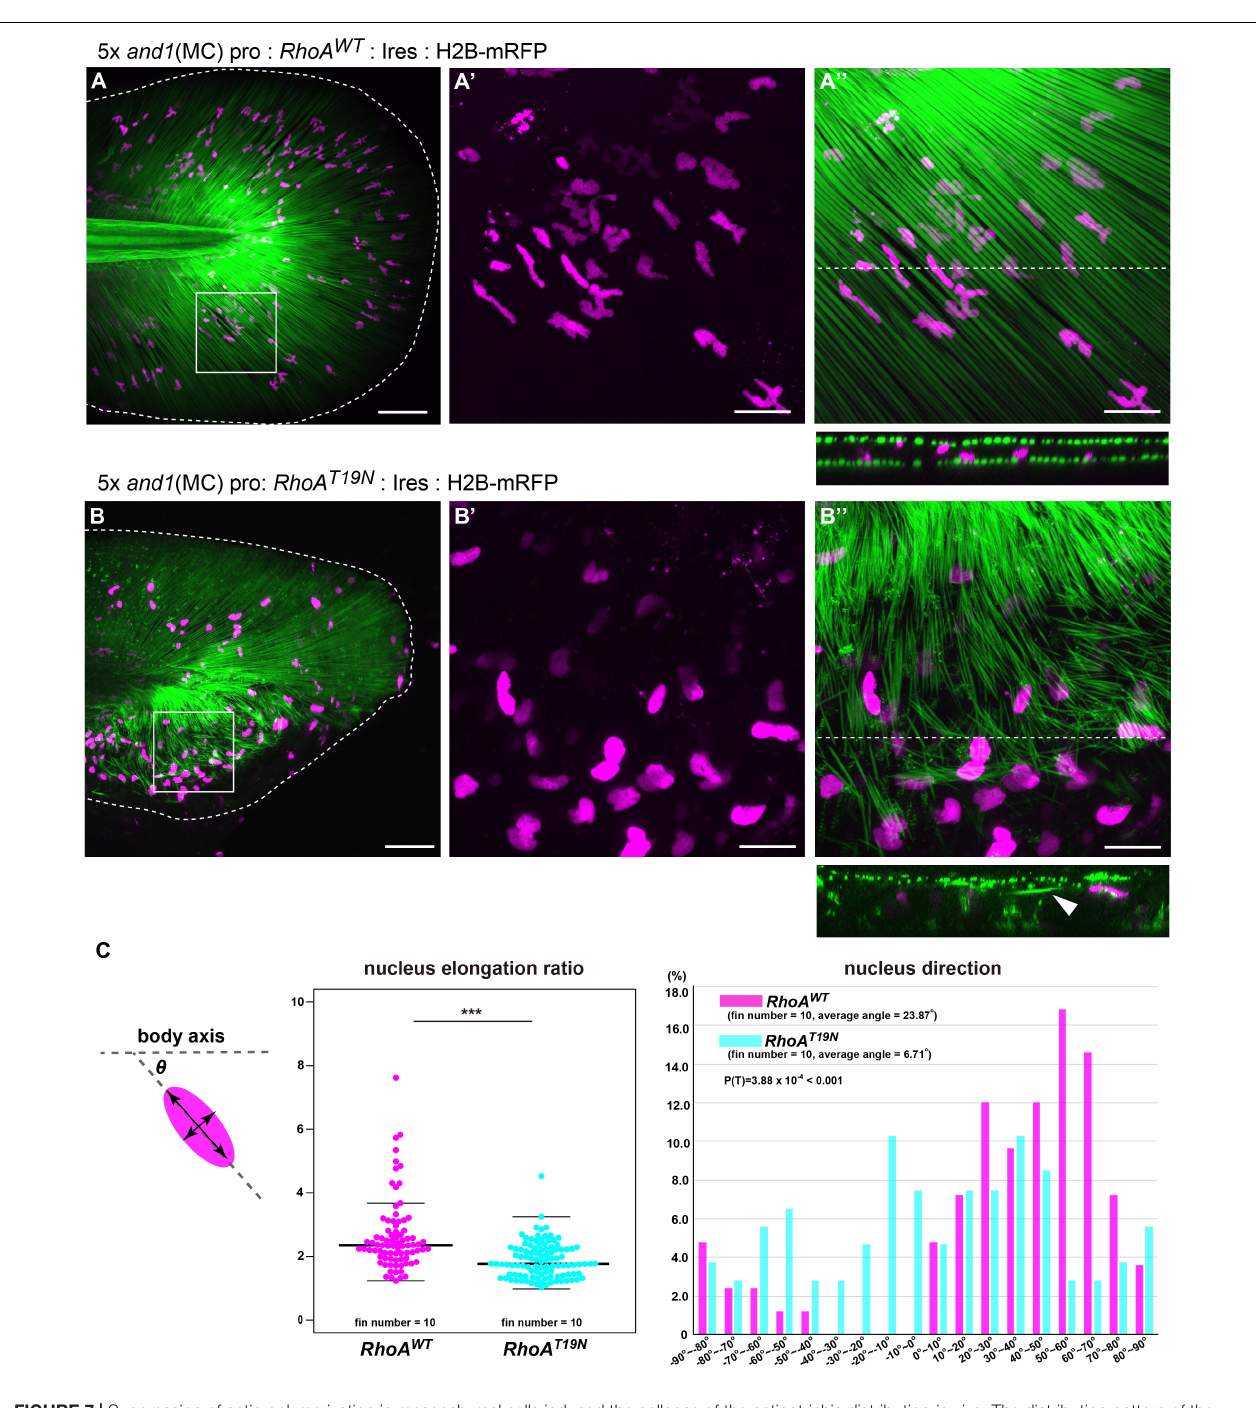
FIGURE 7 | Suppression of actin polymerization in mesenchymal cells induced the collapse of the actinotrichia distribution in vivo . The distribution pattern of the actinotrichia and the nuclei of mesenchymal cells in the TG larva (3 dpf) expressing the wild-type RhoA (A) or dominant negative form of RhoA (B) in mesenchymal cells. The actinotrichia and nuclei of mesenchymal cells were visualized by And1 full -GFP (green) and H2B-mRFP (magenta) respectively. (A (cid:48) ,A (cid:48)(cid:48) ) The magnified images of the white box in (A) . (A (cid:48) ) Nuclei of mesenchymal cells and (A (cid:48)(cid:48) ) nuclei of mesenchymal cells and actinotrichia are shown. The transverse section image at the white dot line in (A (cid:48)(cid:48) ) is shown at the lower panel. (B (cid:48) ,B (cid:48)(cid:48) ) The magnified images of the white box in (B) . (B (cid:48) ) Nuclei of mesenchymal cells and (B (cid:48)(cid:48) ) nuclei of mesenchymal cells and actinotrichia are shown. The transverse section image at the white dot line in (B (cid:48)(cid:48) ) is shown at the lower panel. Aberrant actinotrichia were distributed in a space between the two actinotrichia layers (white arrowhead). (C) The nucleus elongation ratio in mesenchymal cells expressing RhoA DN is much lower than that in the control. The nucleus direction of mesenchymal cells in control larvae showed a radial distribution pattern, whereas, it was randomized in the larvae overexpressing RhoA DN . The nucleus of mesenchymal cells in the ventral-mid area of median fins were measured. P -values: *** P < 0.0001. Scale bars: 50 µ m in (A,B) , 20 µ m in (A (cid:48) ,A (cid:48)(cid:48) ,B (cid:48) ,B (cid:48)(cid:48) ) .